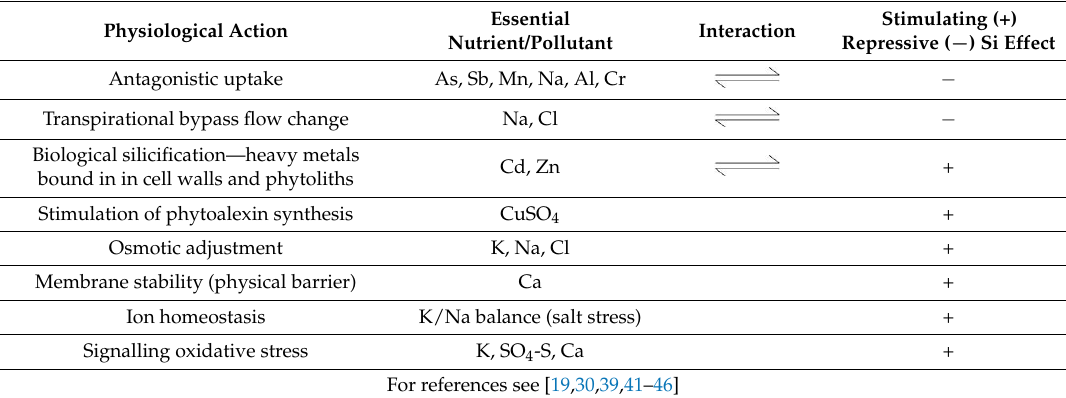
Table 2. Silicon, essential plant nutrients, and pollutants involved in the regulation of some stress related physiological processes.